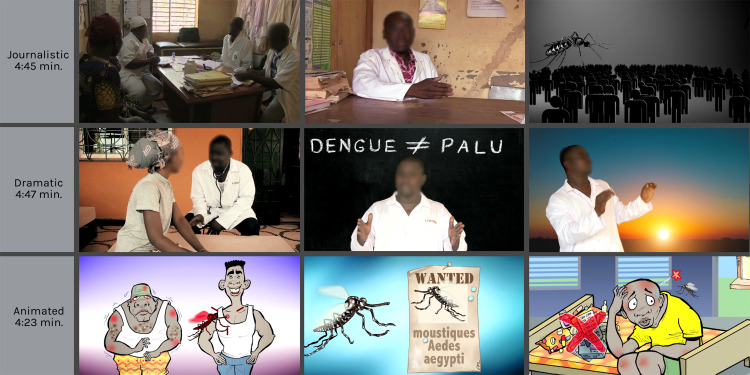
Overview of the narrative genres of the videos.